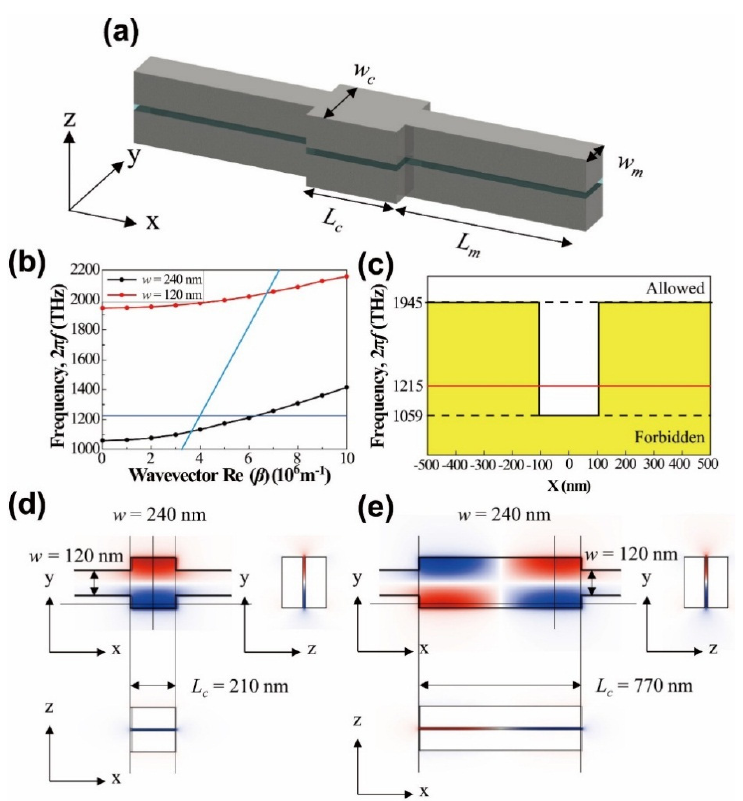
Figure 2. ( a ) Schematic of a cavity consisting of a broad waveguide ( w = 240 nm) and two narrow mirror waveguides ( w = 120 nm). Here, h = 100 nm, t = 10 nm, L m = 1000 nm, and the cavity length is L c ; ( b ) Dispersion curves of first ‐ order waveguide modes for waveguide widths of w = 240 nm (black) and w = 120 nm (red); their cutoff frequencies (cutoff wavelengths) are 2 π f = 1059 THz (1779 nm) and 1945 THz (968 nm), respectively. The horizontal blue line indicates a frequency (wavelength) of 1215 THz (1550 nm). The light line is indicated by the blue line; ( c ) Cutoff frequency of the first ‐ order waveguide mode along the x ‐ axis for the cavity in ( d ). The allowed and forbidden regions are indicated by white and yellow colors, respectively. The allowed frequency region for the first ‐ order waveguide mode is spatially changed by modulating the waveguide width; ( d , e ) Top and side views of the electric field profiles of the fundamental ( L c = 210 nm) and second ‐ order ( L c = 770 nm) cavity modes, respectively. The solid lines indicate the cross ‐ sections of the side views.